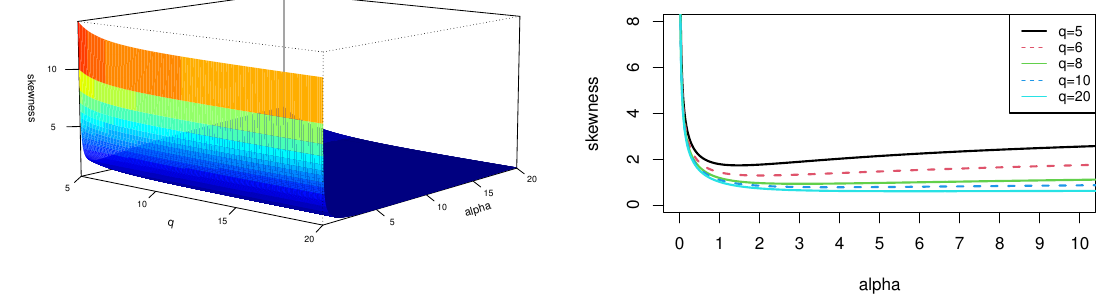
Figure 4. Plots of the skewness coefficient in the SPHN model.